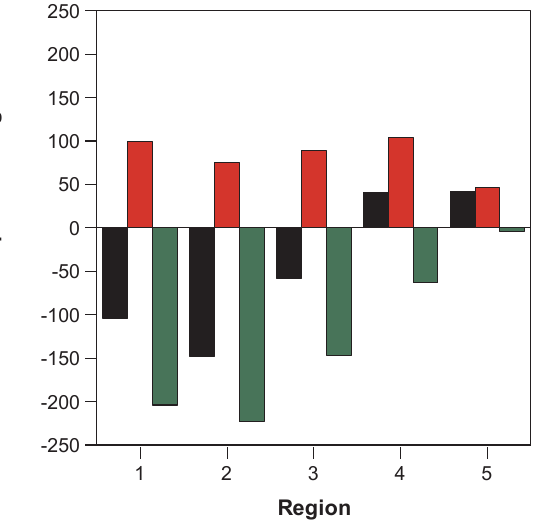
Figure 10 . Temperature and the “net biology” effects on seasonal change in calculated seawater p CO 2 ( µ atm) for the following regions of the Bering Sea shelf: (1) the North Line; (2) the Middle Line; (3) between Nunavak Island and Pribilof Islands, (4) south of the Probilof Islands, and; (5) SE Bering Sea shelf. In the bar chart, the black column denotes the mean observed change in seawater p CO 2 for each region (i.e., δ p CO 2spring-summer in equation 7), while the red and green columns indicates the changes imparted by temperature ( δ p CO 2temperature ) and “net biology” ( δ p CO 2biology ), respectively.